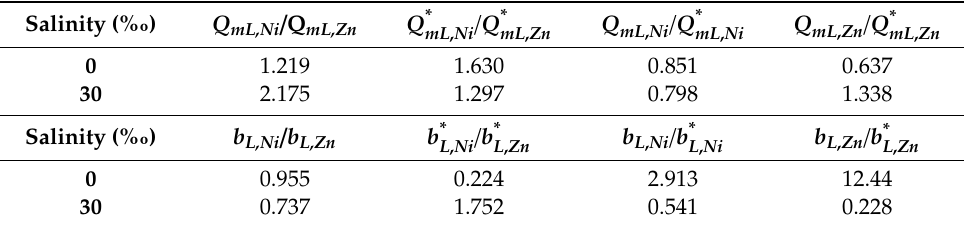
Table 6. Langmuir model parameters for binary adsorption of Ni and Zn onto the sorbents at pH 5. Salinity (% (cid:24) ) Solute Q * (mmol / g) b * (L / mmol) R 2 SSE mL L 0 Ni in Ni / Zn 0.326 ± 0.015 14.38 ± 3.946 0.918 0.017 Zn in Ni / Zn 0.200 ± 0.011 64.31 ± 28.61 0.017 0.254 ± 0.016 0.001